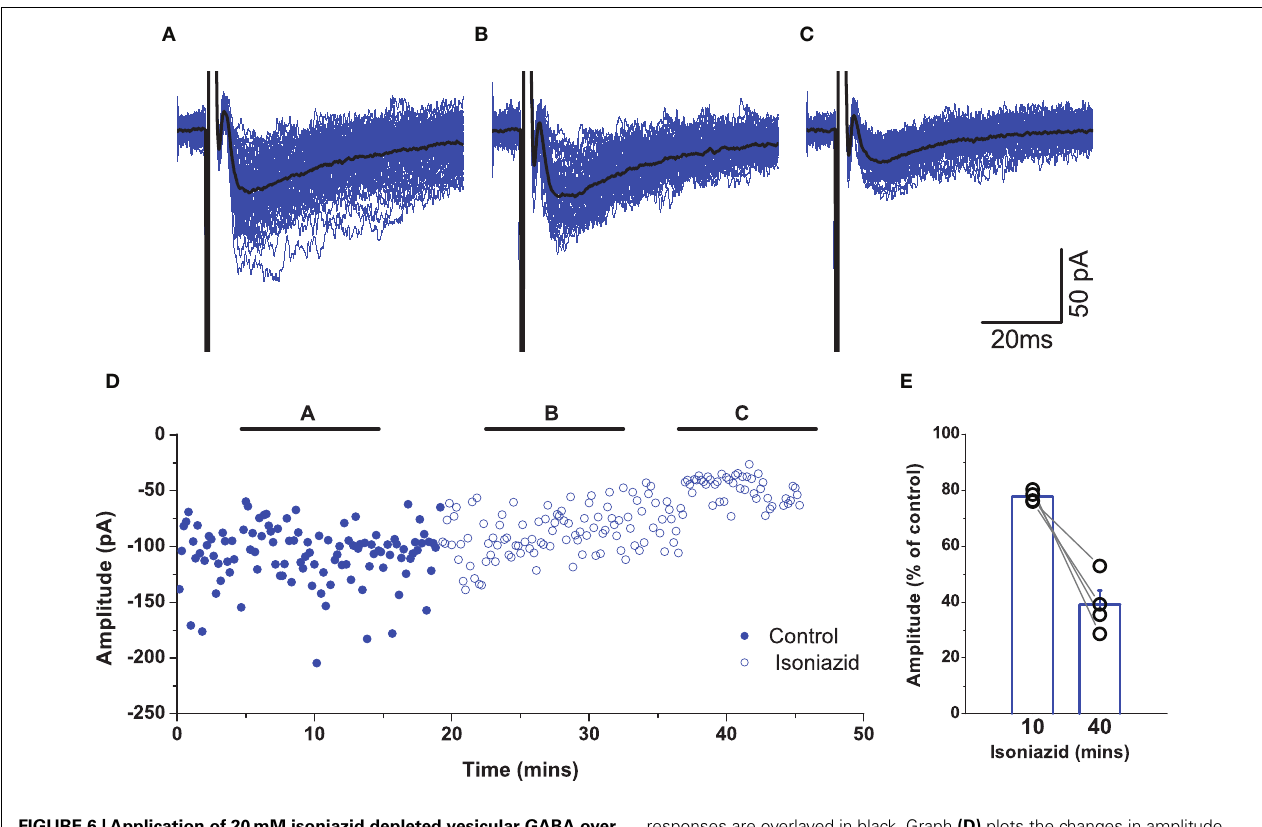
FIGURE 6 |Application of 20mM isoniazid depleted vesicular GABA over a period of 30–45min. In the presence of 1 μ M strychnine, IPSCs were evoked by extracellular stimulation.The traces illustrate an example of a recording of post-synaptic responses during the control period [trace (A) ] and two epochs following isoniazid superfusion [traces (B) and (C) ]. Mean